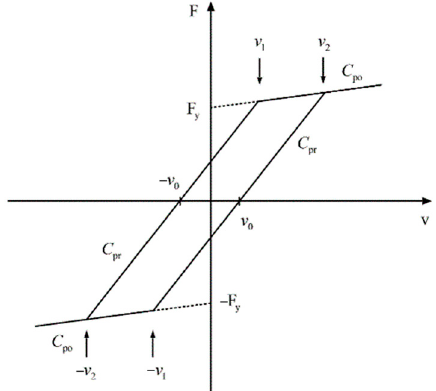
Figure 2. Hysteretic bi-viscous model [17].